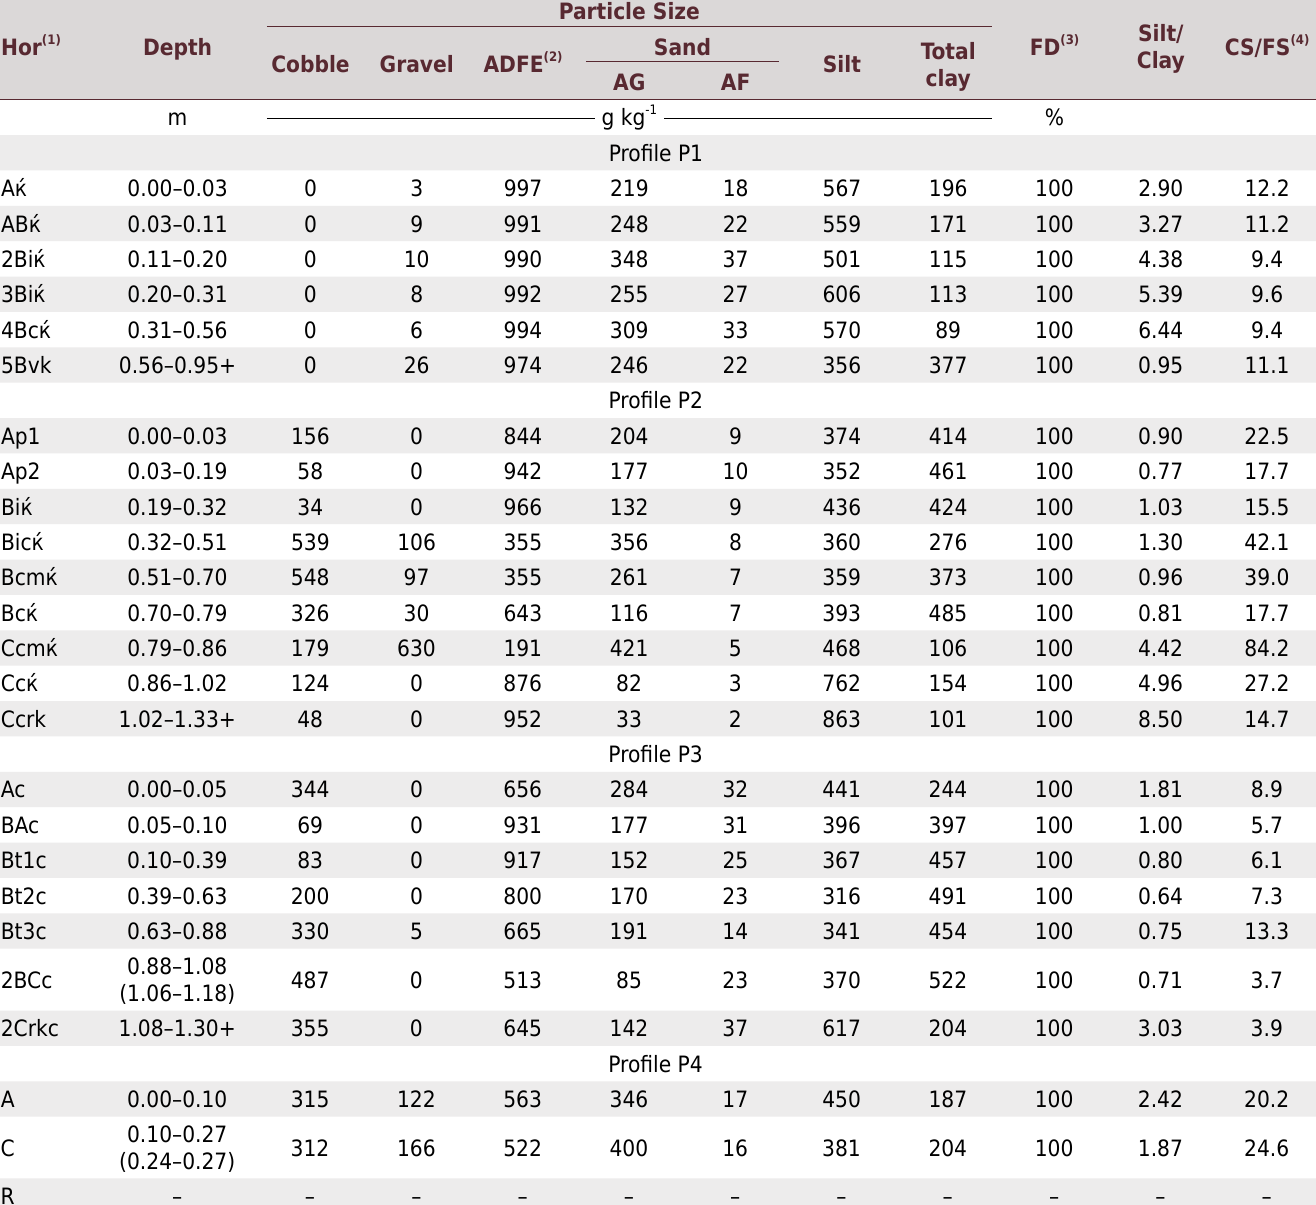
Table 3. Particle size, flocculation degree, silt/clay ratio, and coarse sand/fine sand ratio of soils from the Apodi Plateau Hor